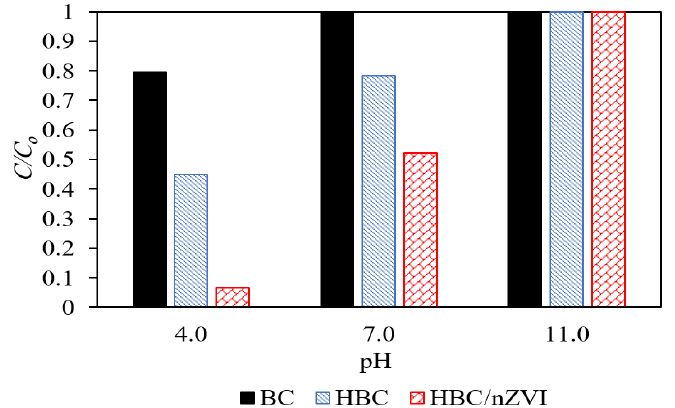
Figure 5. Effects of solution pH on the Cr(VI) removal performance of BC (solid black columns), HBC (blue dashed columns), and HBC/nZVI (red plaid columns). Experimental conditions: Initial Cr(V) concentration = 10 mg L − 1 , reaction time = 24 h, adsorbent dose = 1.5 g L − 1 .